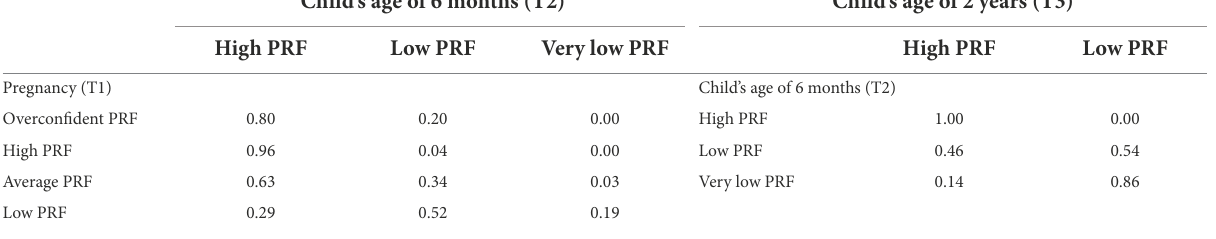
TABLE 4 Estimated transitional probabilities for the maternal PRF profiles.